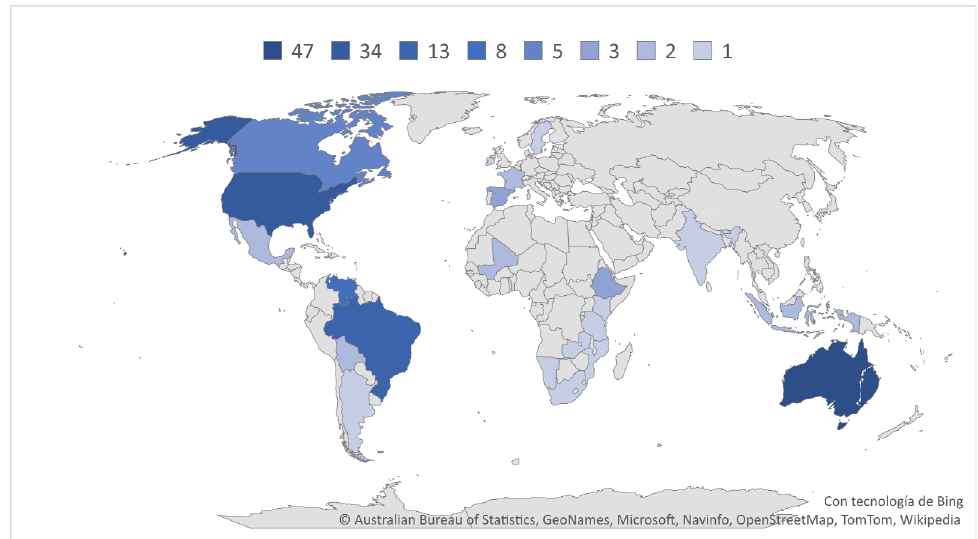
Figure 3. Number of papers focusing on each territory based on the contributions analysed in the sample.